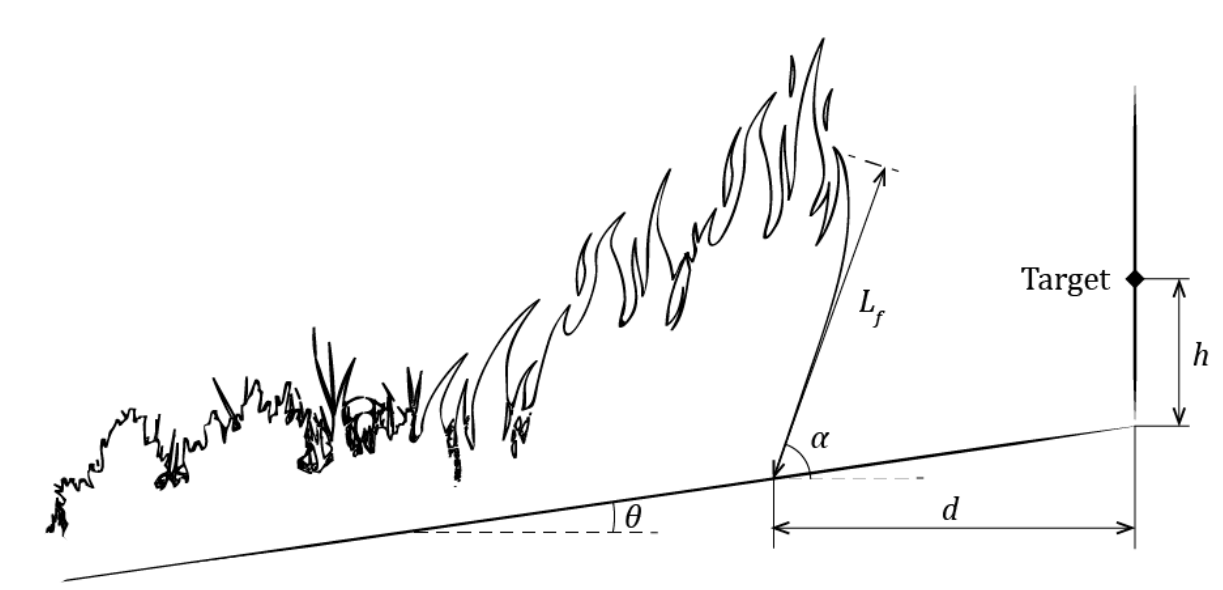
Figure 4. Configuration of fire front and the target, as presented in AS3959 [40].